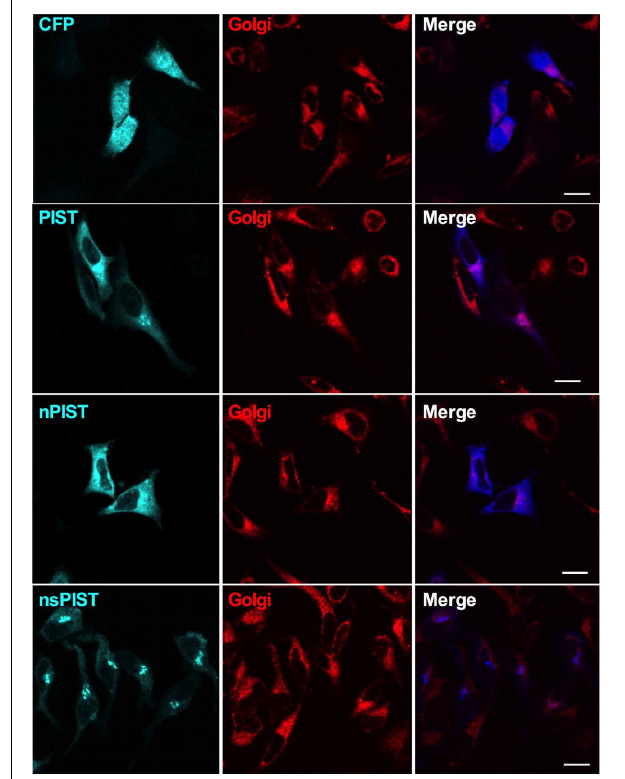
FIGURE 5 | Single confocal slices of cells expressing CFP-tagged PIST isoforms (blue). The Golgi apparatus was stained with BODIPY-C5 ceramide (red). Scale bar, 10 μ